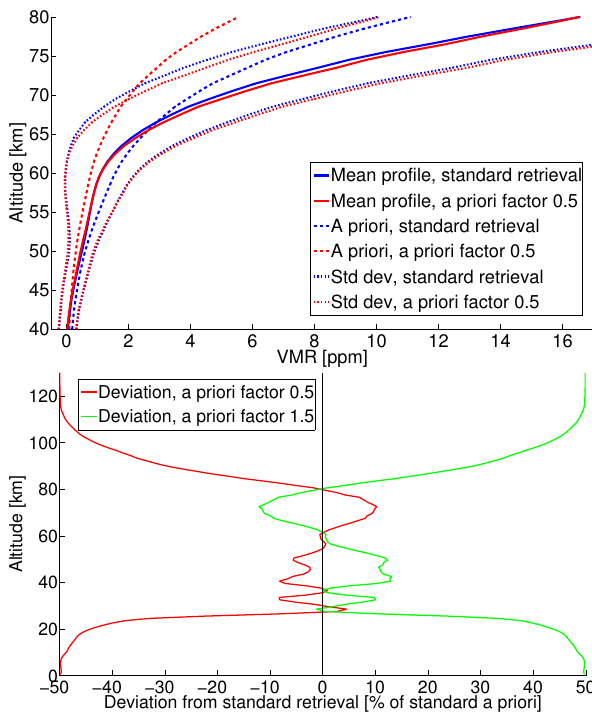
Fig. 8. Test of the retrieval stability when the a priori is changed by a factor of 0.5 or 1.5 respectively. Top panel: mean profiles, associated standard deviations, as well as a priori profiles for the standard retrieval and one modified retrieval setup (factor 0.5) in the range of sensitivity between 40 and 80km. It is obvious, that the change of the mean profile introduced by an a priori change is much smaller than the standard deviation, which is mainly produced by the annual variability. Profiles of the factor 1.5 case behave sim- ilarly and are not shown. Bottom: deviation of the mean profiles of both modified cases from the standard retrieval profile, plotted for the complete vertical range, normalized with the standard a priori. The deviation is small in the range of sensitivity between 40 and 80km and approaches, as expected, 50% where the sensitivity van- ishes